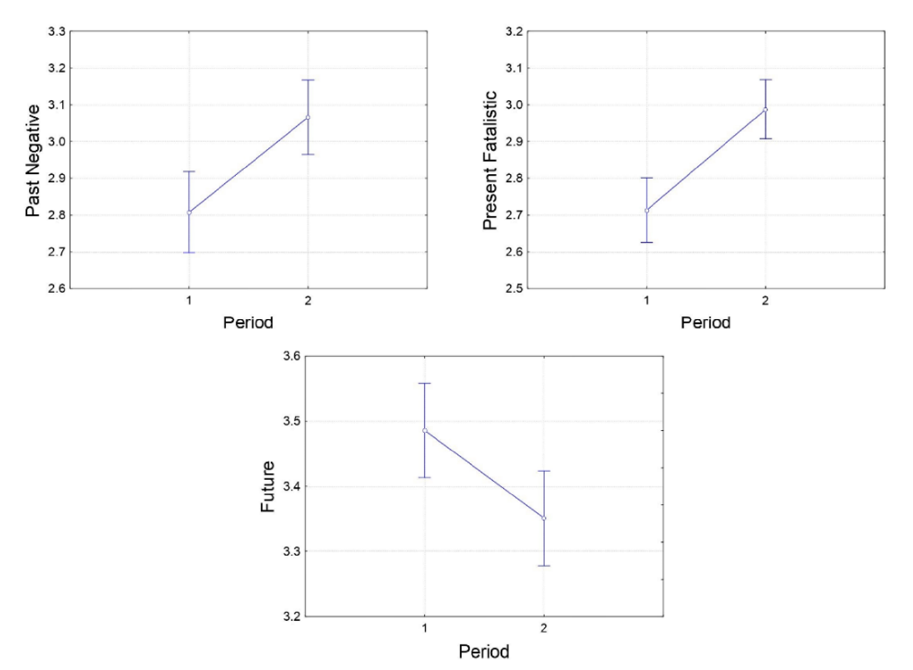
Figure 2. Graphs of significant differences in the past-negative , present fatalistic , and future time orientations observed from pre-crisis to crisis periods in the south-eastern Ukrainian regions. Axis “period”: 1—pre-crisis subgroup 1 (March 2013–November 2013), 2—crisis group (April 2014–May 2015).